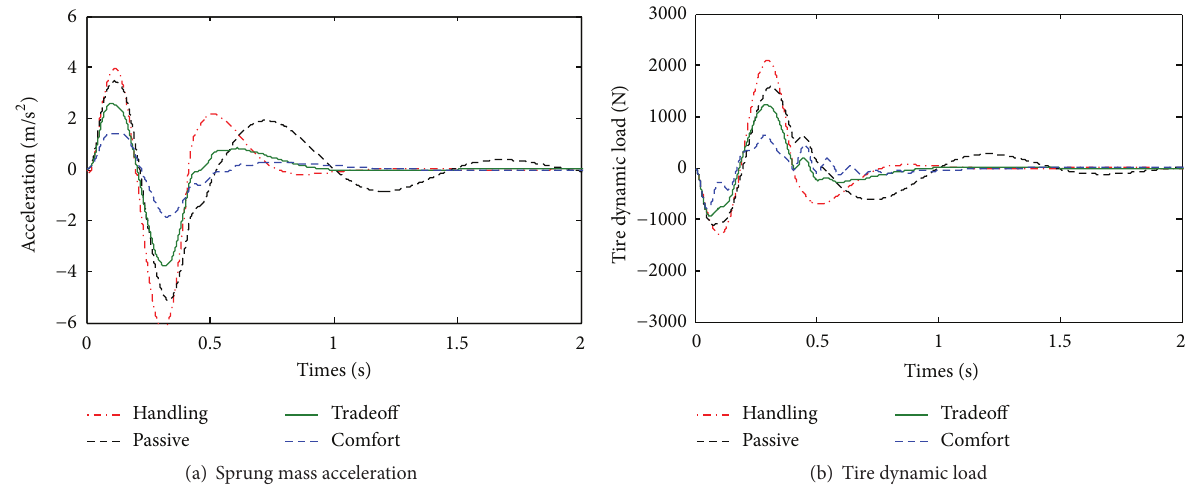
Figure 15: Actual responses of the proposed suspension comparing to passive suspension.